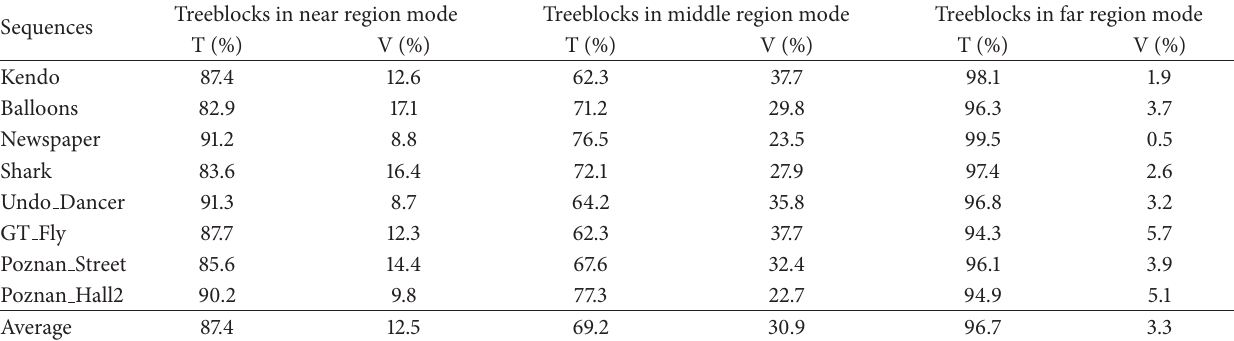
Table 3: Analysis of view prediction and temporal prediction distributions for three treeblocks types.